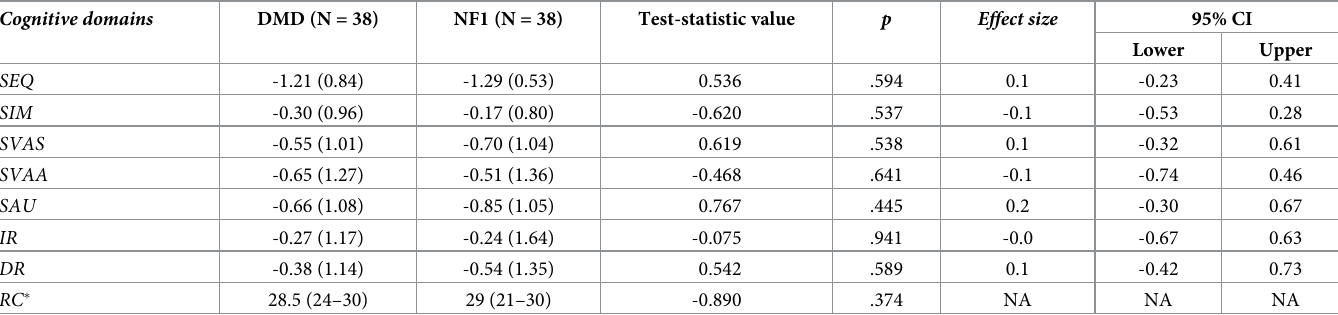
Note: Z-scores are mean (SD) except of � outcomes are raw median (range) scores, Test-statistic values are t-values, except of � is z-value, Effect size = Cohen’s d, 95%